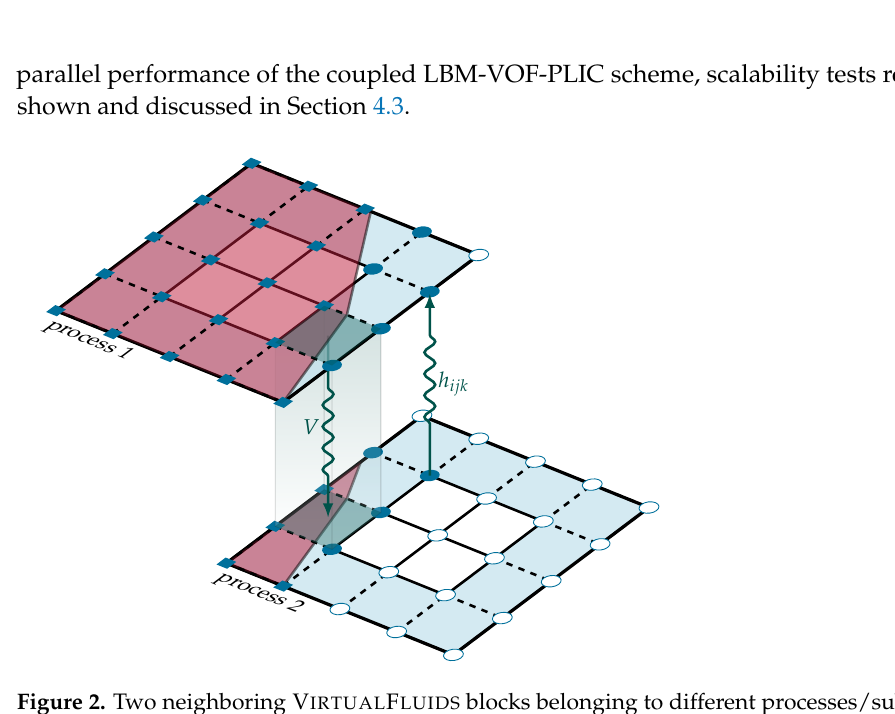
Figure 2. Two neighboring V IRTUAL F LUIDS blocks belonging to different processes/subdomains. Within each time step, both blocks exchange